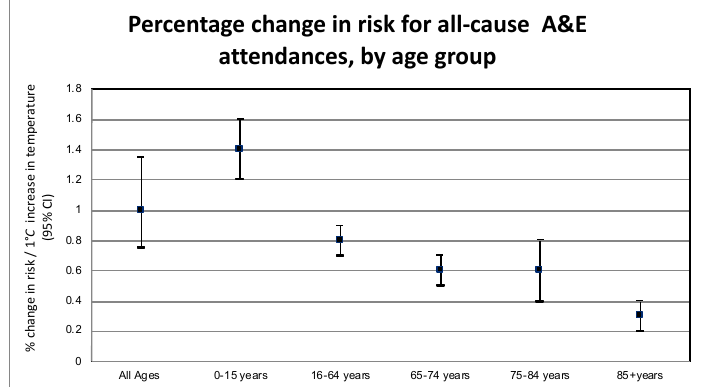
Figure 3. Risk of attending an A&E department per 1 °C increase in mean temperature for all causes, by age group.